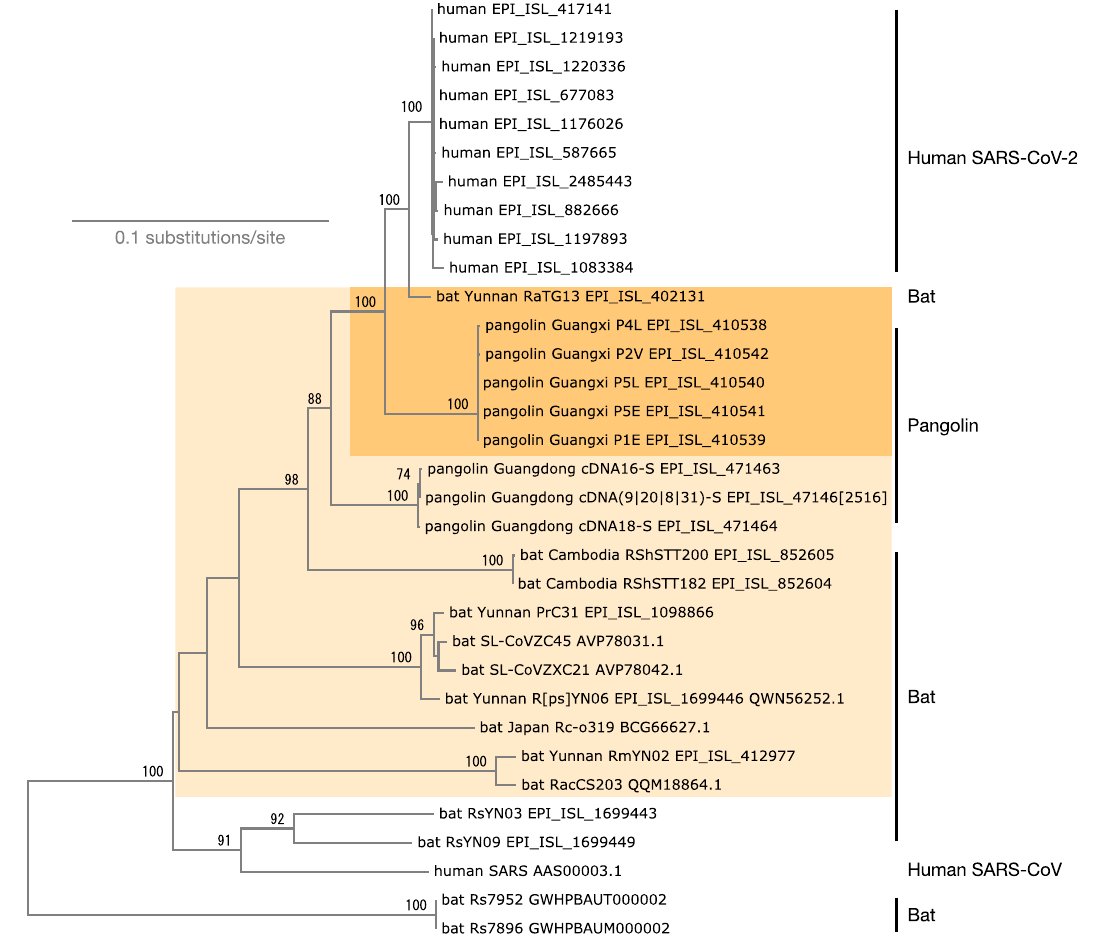
Fig. 3 Outgroup sequences used as “ original ” (dark orange) and “ broad ” (light orange), displayed on a simple tree. Bootstrap values larger than 70% Accession number in GISAID, genbank or National Genomics Data Center is given for each